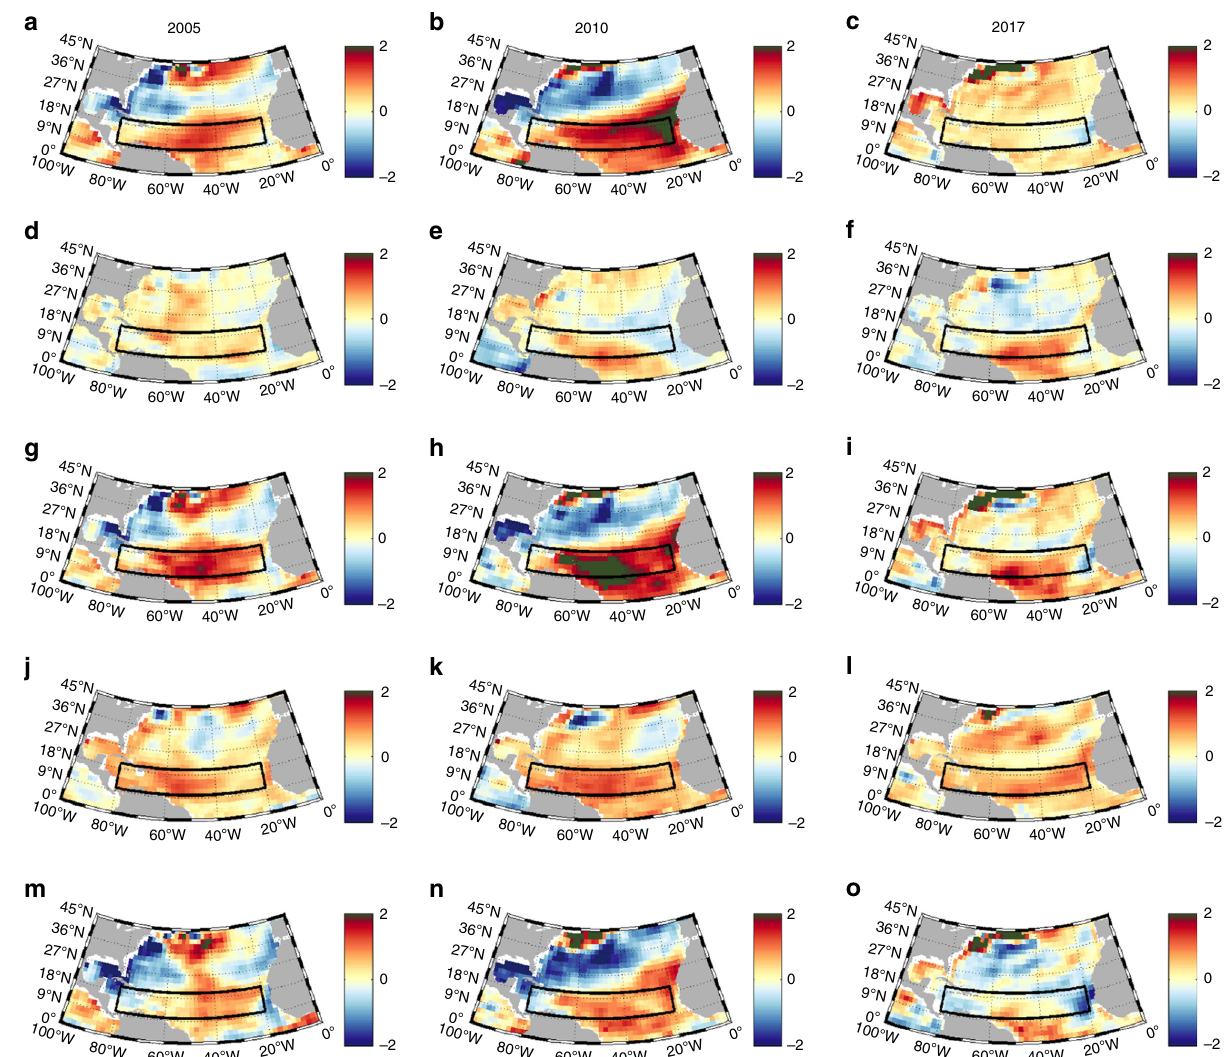
Fig. 5 Surface Flux generated Temperature Anomaly April – July for 2005, 2010 and 2017. Initial condition — SSTA March ( a – c ). Estimated temperature anomaly April – July based on anomalous surface fl uxes ( d – f ). Estimated SSTA in August formed by summing the initial condition and April – July surface fl ux generated temperature anomaly ( g – i ). Observed SSTA in August ( j – l ). Estimated minus observed August SSTA ( m – o ). Black box indicates MDR